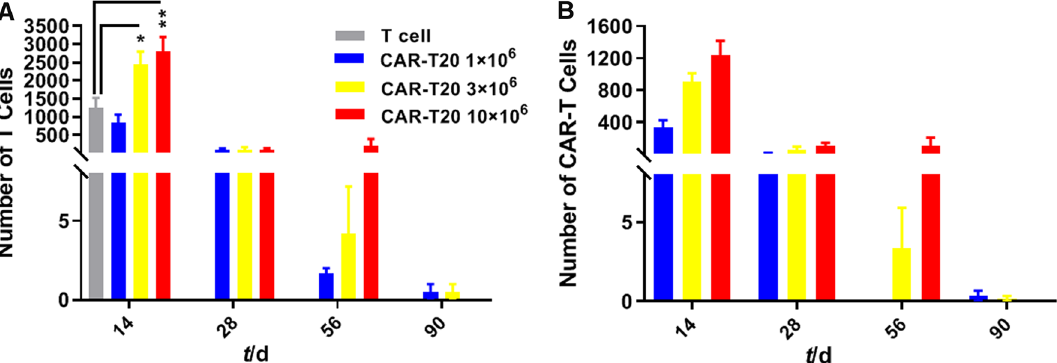
Fig. 4 Proliferation of lymphocytes with T cells and CAR-T cells in animals administrated with CAR-T20. The NSG mice bearing Raji-Luc cells were administered with 1, 3 and 10 × 10 6 CAR-T 20 respectively, and observed for 90 days. The counts of T cells ( A ) and CAR-T ( B ) cells were analyzed by flow cytometry method. The amounts of T cells and CAR-T in animals dosed with CAR-T20 reached the peak at 14 days post administration and decreased afterwards with a dose–response tendency. T cells in the T cell group increased predominantly from 14th to 28th day post administration. Data are shown as the mean ± SD (n =